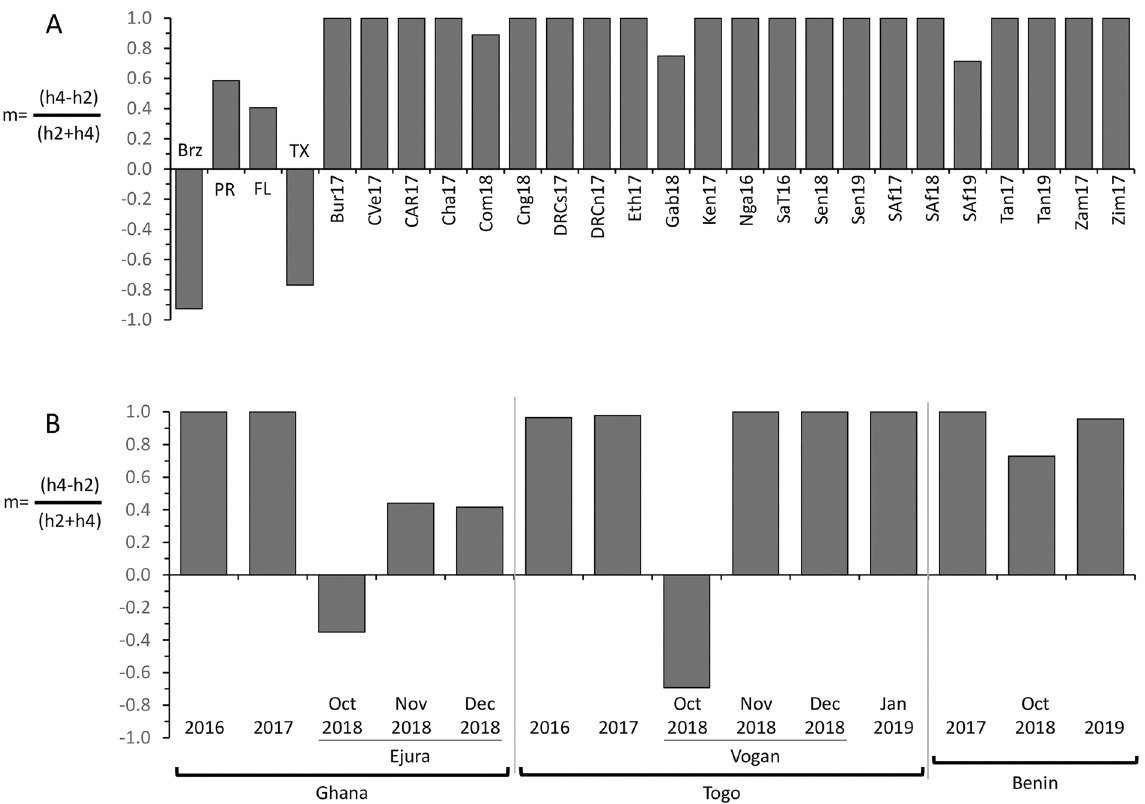
Figure 6. Bar graphs describing the m-values calculated for different collections as described in Table 1. ( A ) compares the m-values for various sites in Africa with those observed with FAW from Brazil (Brz), Puerto Rico (PR), Florida (FL), and Texas (Tx). ( B ) describes the m-values for collections from Ghana, Togo, and